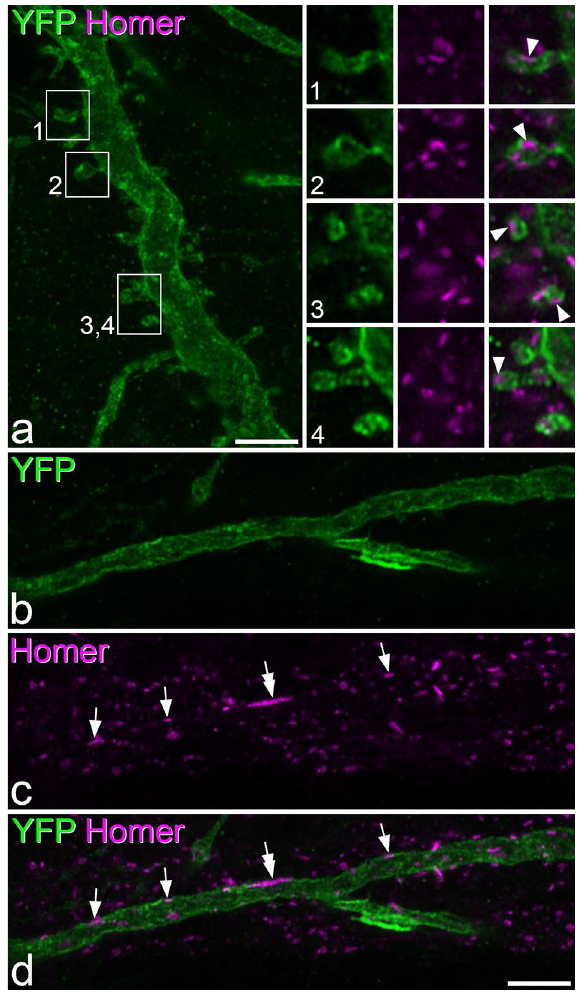
Figure 11. Homer puncta on the dendritic shafts and spines of YFP-positive lamina I cells in Phox2a::Cre;Rosa26 LSL- ChR2-EYFP mice. ( a ) A region of dendrite from Cell 3 (shown in Fig. 9) that has numerous dendritic spines. The insets show higher magnification views of these spines. The tissue has been reacted to reveal YFP (green) and Homer (magenta). Homer puncta can be seen in each of the dendritic spines (arrowheads) in the insets. ( b – d ) Part of a dendritic shaft from the same cell. This region has few dendritic spines, but there are several Homer puncta in the membrane (arrows). One of these (double arrow) is particularly large (approximately 3 μm long). Confocal images are projections of 11 optical sections (main part of ( a ) and 4 optical sections ( b – d ) all at 0.3 μm z-separation. Insets in ( a ) are all single optical sections. Scale bars: ( a,b – d ) = 5